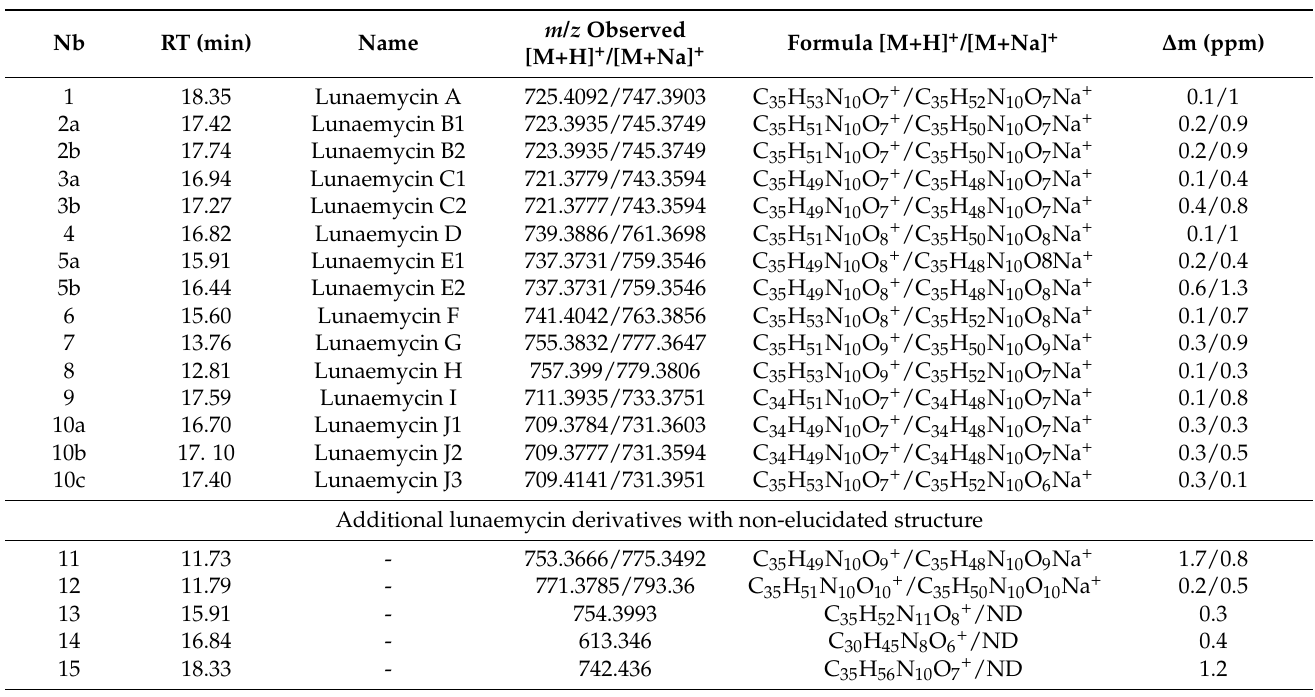
Table 3. Lunaemycins produced by S. lunaelactis MM109 T and